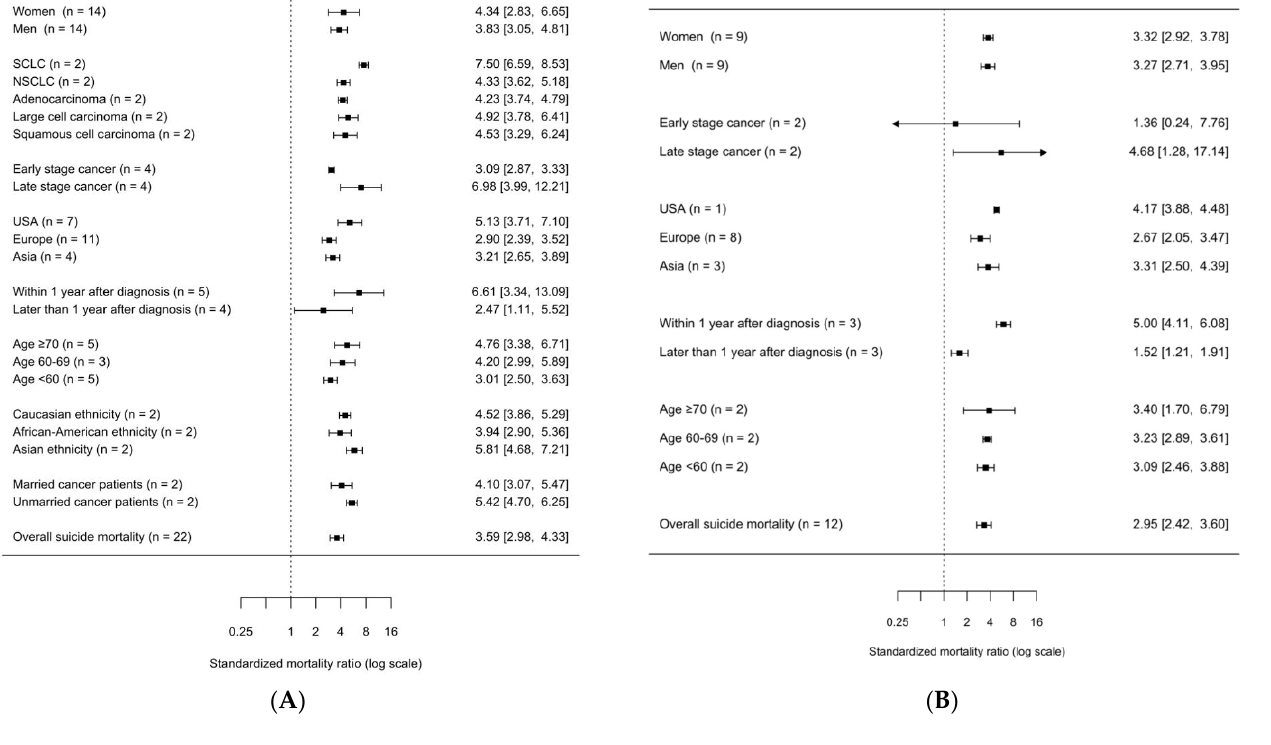
Figure 4. Summary forest plot of subgroup analyses of suicide in patients with lung-cancer. ( A ) All 23 studies sorted by risk estimate. I 2 = 85.70%, P-heterogeneity = 0.0000. ( B ) 12 studies sorted by risk estimate. I 2 = 90.29%, P-heterogeneity = 0.0000. Abbreviations: SMR, standardized mortality ratio; CI, confidence interval; n, number of studies included in the analysis.